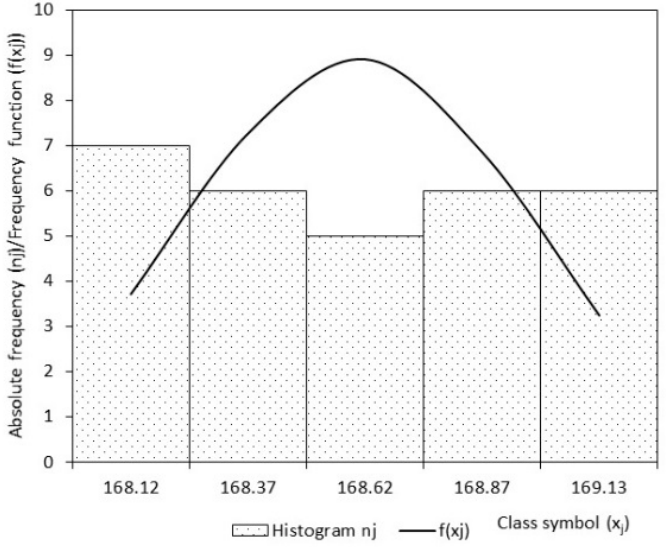
Figure 5. Histogram and frequency function for the width parameter, first day. As the data do not show a normal distribution, it is not possible to verify the stability. process